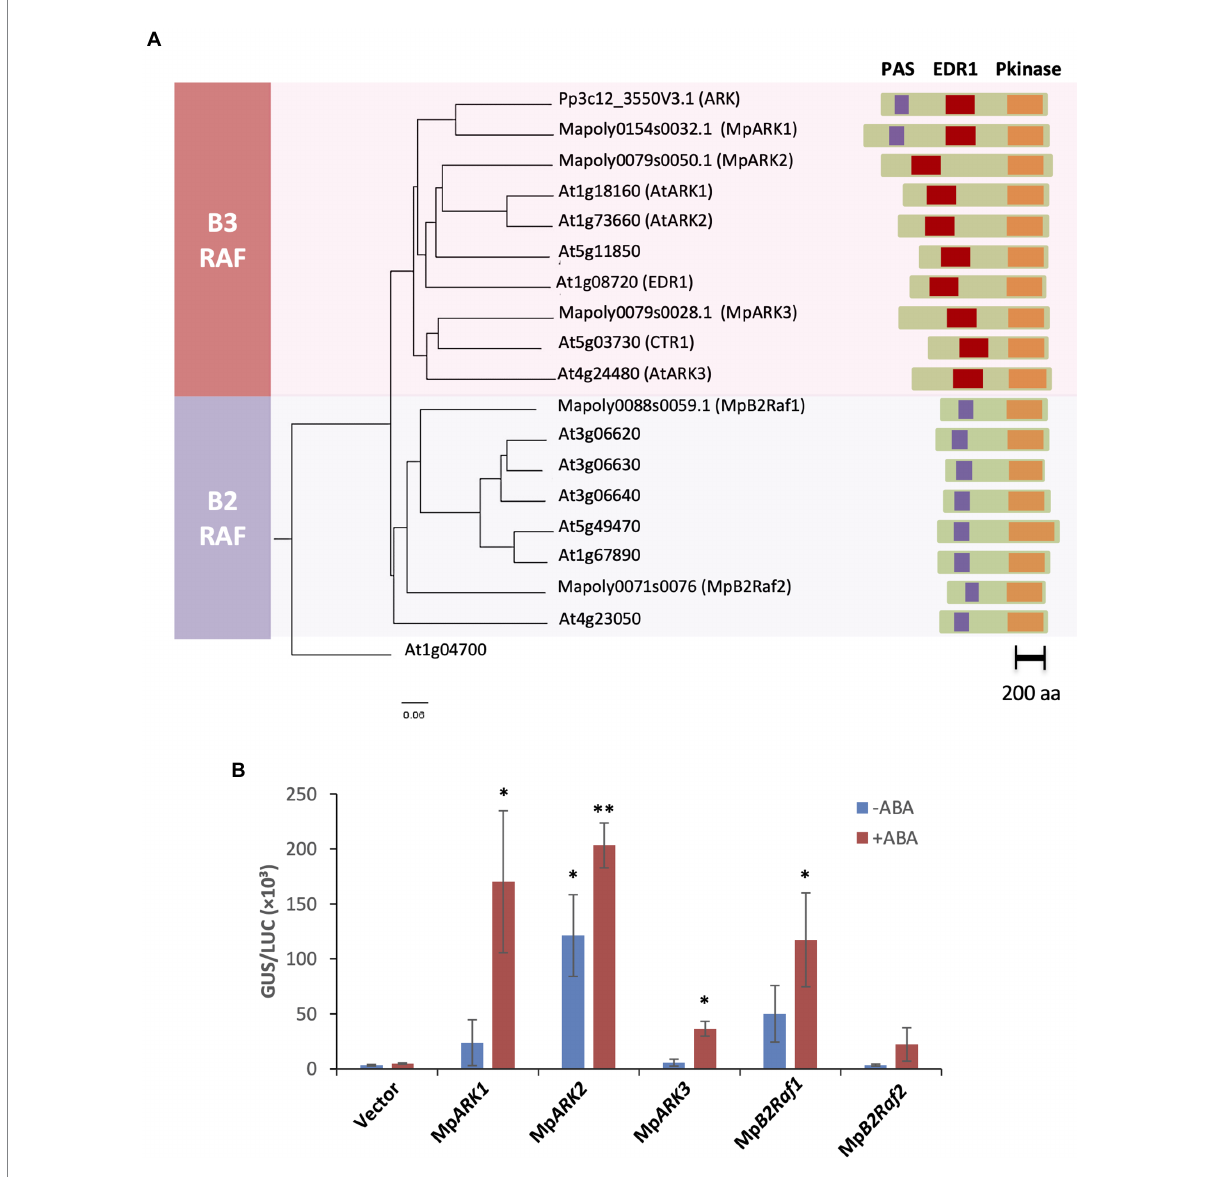
FIGURE 1 (A) Phylogenetic relationships and polypeptide structures of group B2 and B3 Raf kinases. The phylogenetic analysis was conducted by the neighbor-joining method using CLASTALW. Numbers on the branches indicate bootstrap values (100 replicates) and the bar represents the number of amino acid changes per branch length. (B) Reporter assays of ark mutant of P. patens using cDNA constructs of group B2 and B3 Raf kinases of M. polymorpha . The constructs of cDNA fused to the rice actin promoter, proEm-GUS and proUbi-LUC were introduced into protonema cells by particle bombardment. The vector without cDNA was used as a control. The bombarded cells were cultured for 1 day with or without 10- μ M ABA before GUS and LUC assays. Levels of gene expression are represented by GUS/LUC ratio. Error bars indicate standard error of the mean. * p < 0.05 and ** p < 0.01 in the t -test ( n = 3) compared with WT of the same